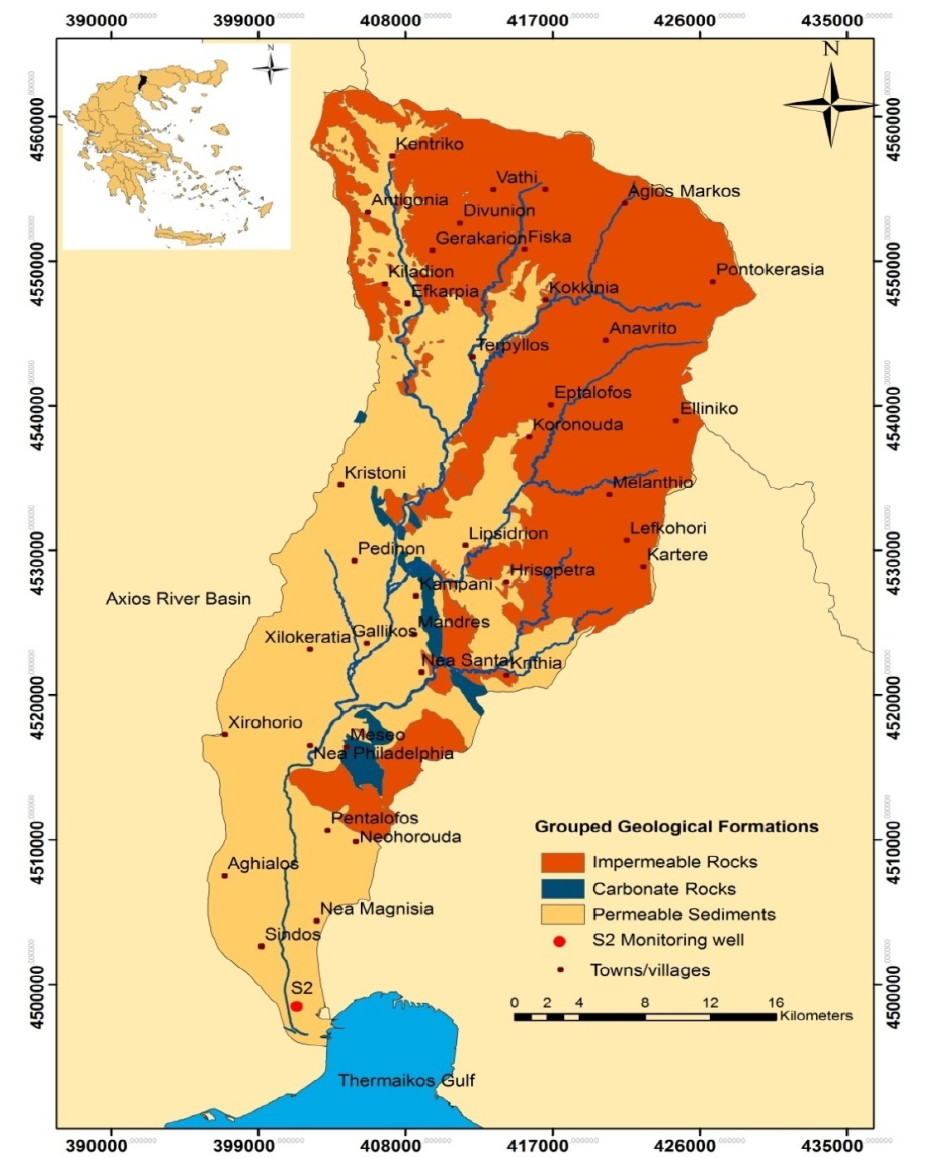
Figure 7. Grouped geological formations in the Gallikos River